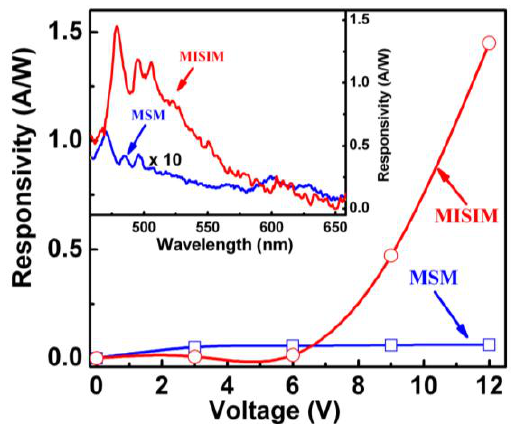
Figure 6. Responsivity of the Si based MISIM and MSM photodetectors as a function of the applied bias. The inset shows the photoresponse of the MISIM and MSM structured Si photodetectors measured at 12 V bias (note that the responsivity of the MSM photodetector has been magnified by 10